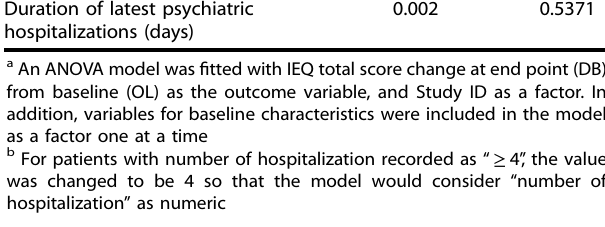
Table 3. Relationship between change in IEQ total score, baseline characteristics (categorical variables) and improvement in